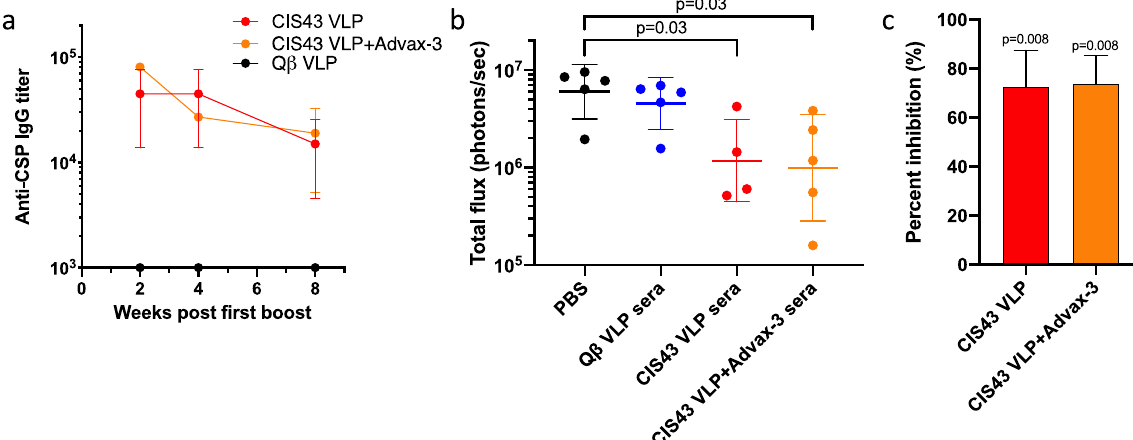
Fig. 5 Cynomolgus monkeys immunized with CIS43 VLPs produce protective anti-CSP antibodies. a IgG concentrations in cynomolgus monkeys immunized at weeks 0 and 4 with CIS43 VLPs with or without Advax-3 adjuvant ( n = 3/group). Q β VLPs were used as a negative control. b Parasite liver load (as measured by luminescence) in mice ( n = 4 – 5/group) that received an intravenous injection of 500 µl of sera from immunized cynomolgus monkeys. Two hours following serum transfer, mice were challenged with fi ve Pb-Pf CSP -Luc infected mosquitoes. Mann – Whitney test was used to statistically compare each group to the group that received an intravenous injection with PBS. c Percent inhibition of liver infection, as calculated from luminescence data. Inhibition of infection is calculated relative to the mean signal in the control groups. Mann – Whitney test was used to statistically compare each group to all control groups. Error bars represent